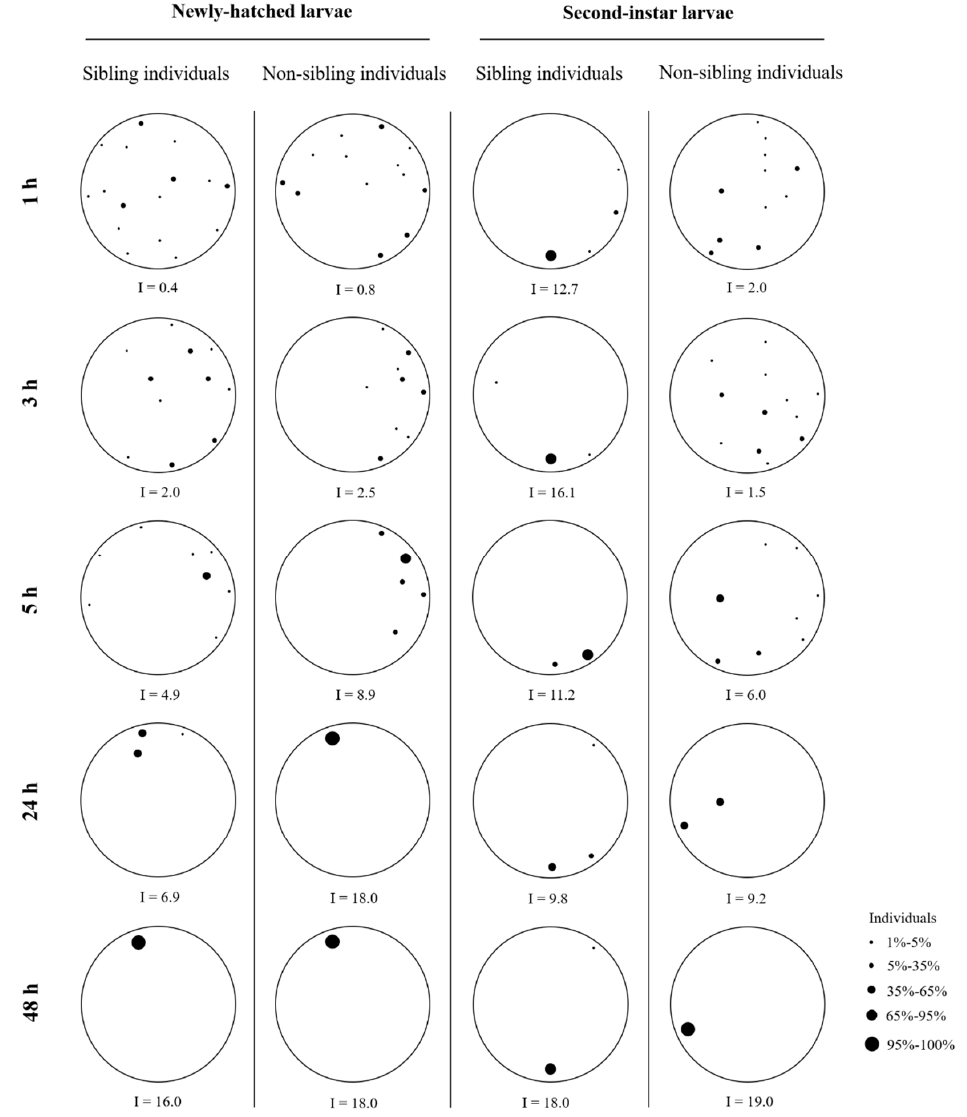
Figure 4. Examples of aggregation behavior of newly hatched or second-instar larvae of Heortia vitessoides in the arena containing sibling individuals (20 larvae originated from the same sibling cohort), or non-sibling individuals (10 larvae originated from one sibling cohort and 10 from another sibling cohort).